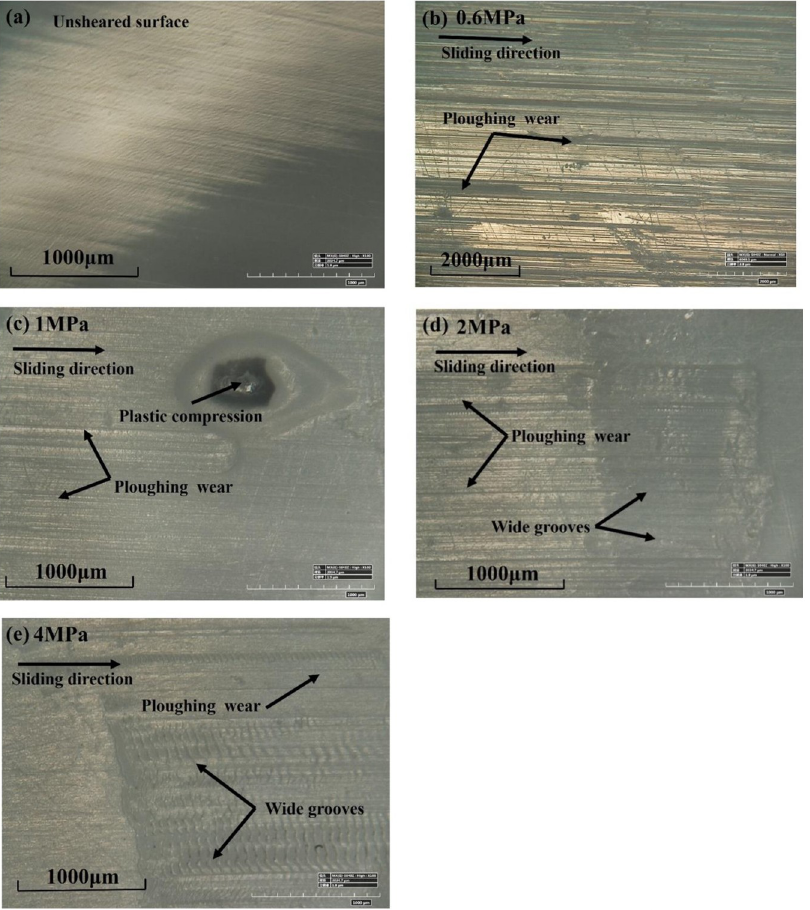
Fig 9. Abrasion and damage images of HDPEs for group D2: (a) Unsheared surface; (b) Sheared surface under normal stress of 0.6 MPa; (c) Sheared surface under normal stress of 1 MPa; (d) Sheared surface under normal stress of 2 MPa; (e) Sheared surface under normal stress of 4